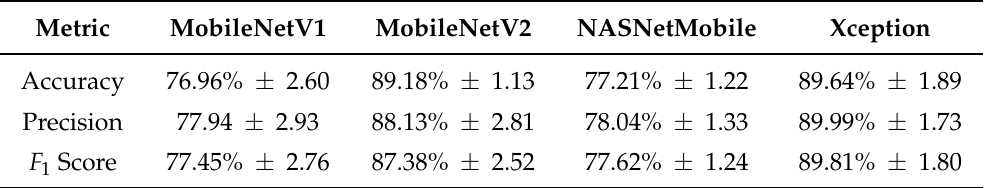
Figure 6. Samples of misclassified images, true classes with prediction values of true class and false predicted classes with corresponding false prediction values. Table 4. Mean values and SDs for weighted metrics of four deep learning models evaluated with 5-fold cross